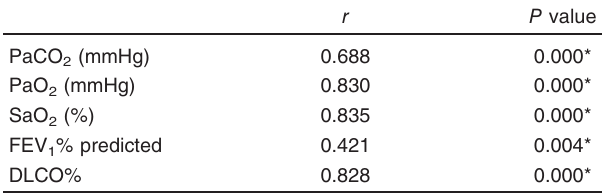
Table 6 Correlation coefficient between each of serum testosterone levels and forced expiratory volume in 1s predicted, diffusion lung capacity for carbon monoxide (%), arterial oxygen tension, and arterial carbon dioxide